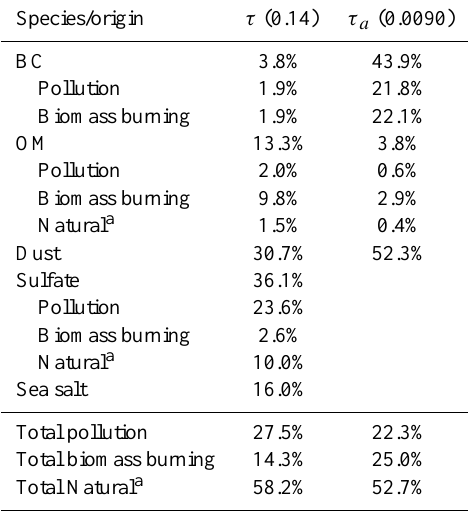
Table 4. Aerosol composition, origin, and the relative contribution to τ and τ a at 550nm for 2007. Numbers in parenthesis are global